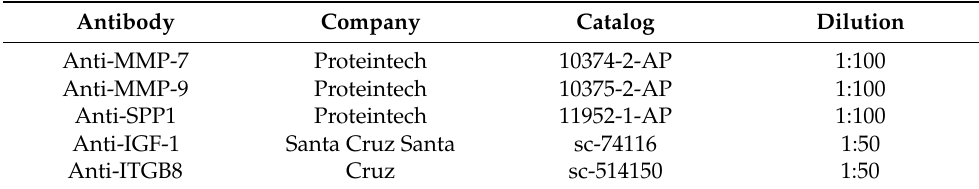
Table 3. Specifications of primary